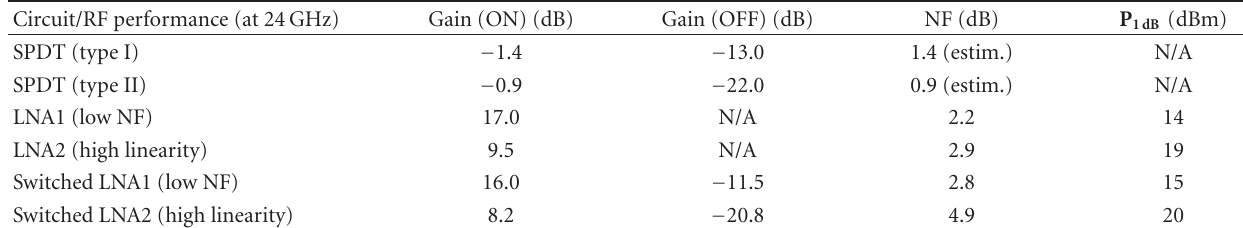
Table 1: Results of RF-MEMS-Switched LNAs and fixed